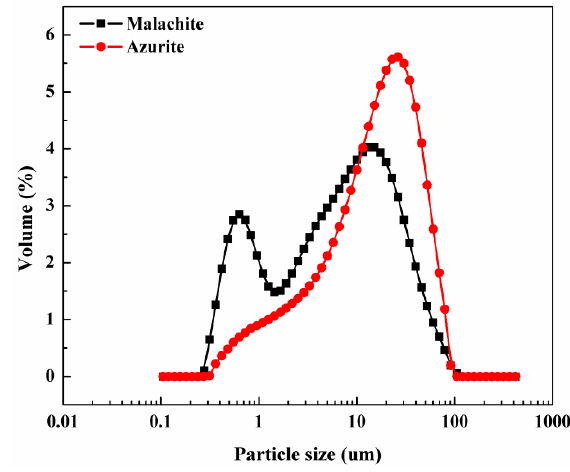
Figure 4. Particle size analysis results of azurite and malachite.